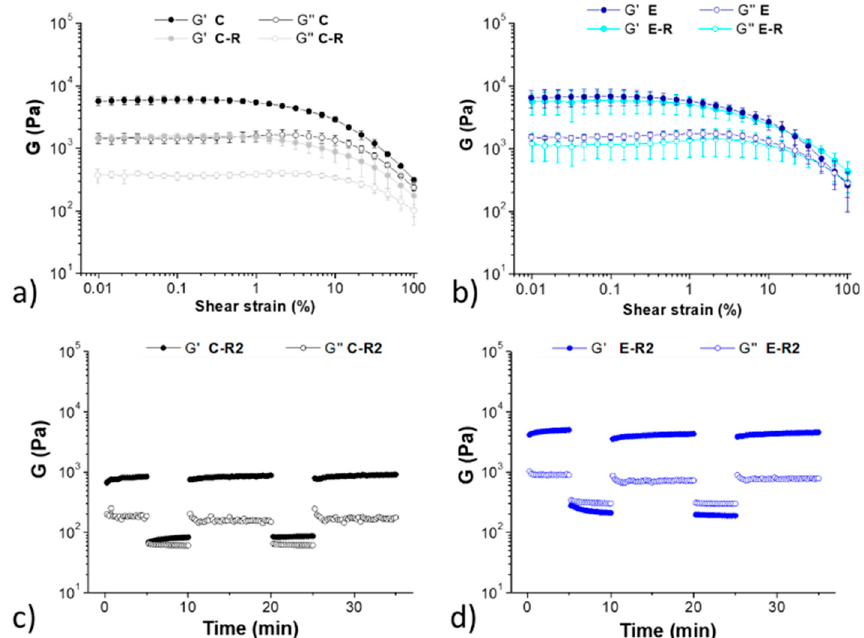
Figure 3. Top: amplitude sweep experiments of the hydrogel C ( a ) before (black) and after (gray) a break/recovery cycle. Amplitude sweep experiments of the hydrogel E ( b ) before (blue) and after (cyan) a break/recovery cycle. The analyses were repeated in triplicate. Bottom: step–strain experiments of hydrogels C ‐ R2 ( c ) and E ‐ R2 ( d ).